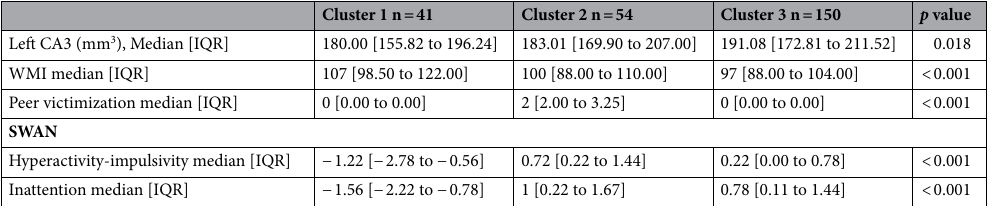
Table 2. Three-cluster model participant